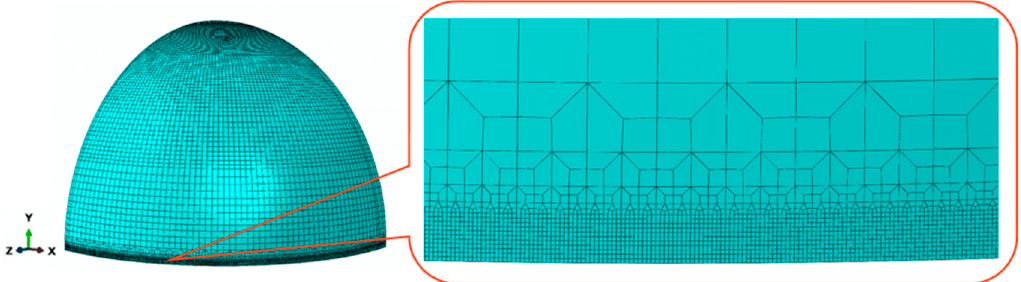
Figure 11. Meshing of the spherical pressure hull model.